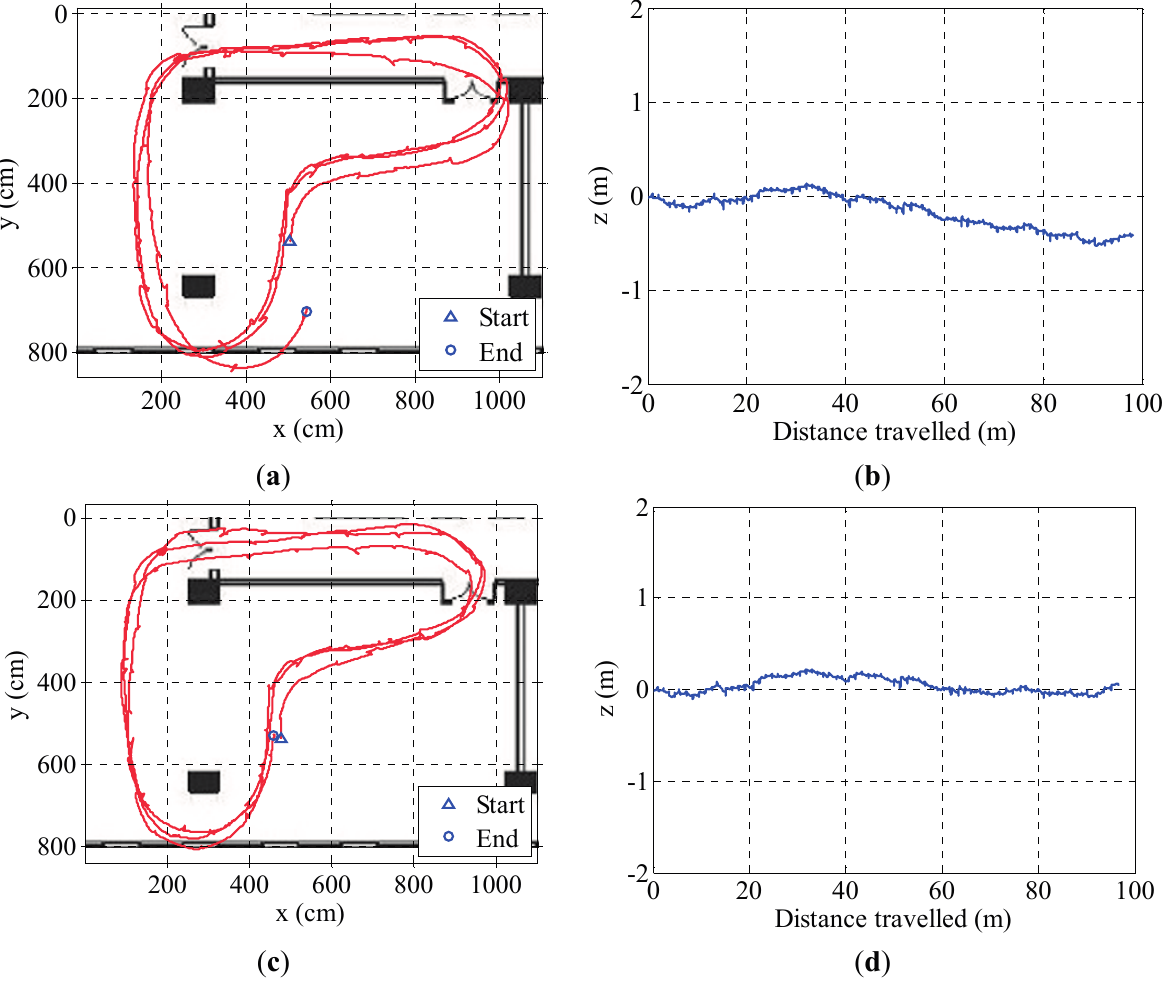
Figure 15. The comparison of the tracking results based on different ZV detectors. ( a ) Estimated 2D path based on the combined condition method; ( b ) Estimated altitude based on the combined condition method; ( c ) Estimated 2D path based on the BN method; ( d ) Estimated altitude based on the BN